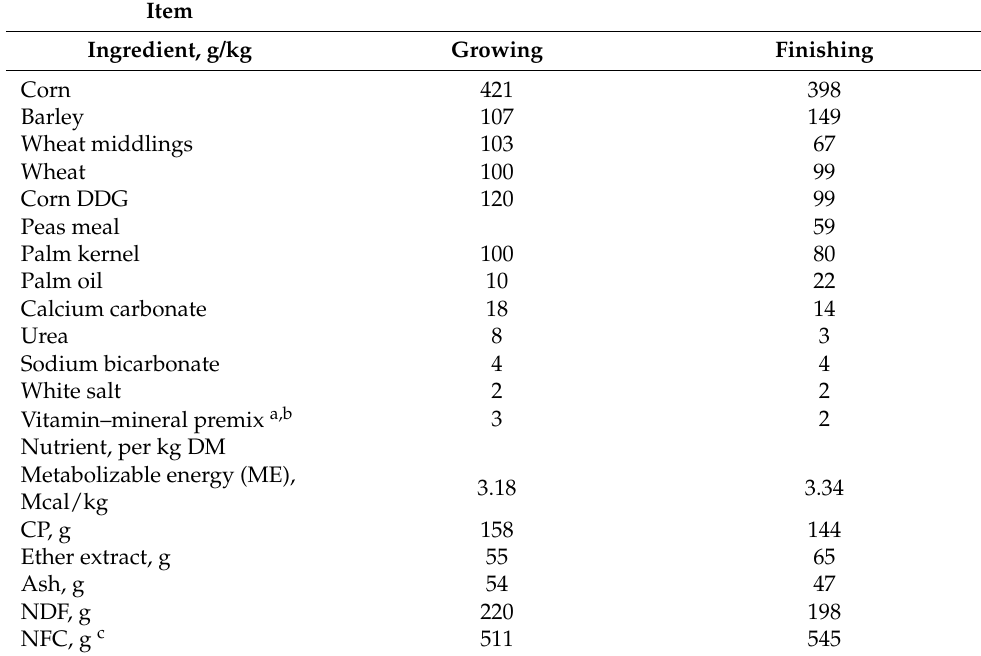
Table 1. Ingredient and nutrient composition of the growing and finishing